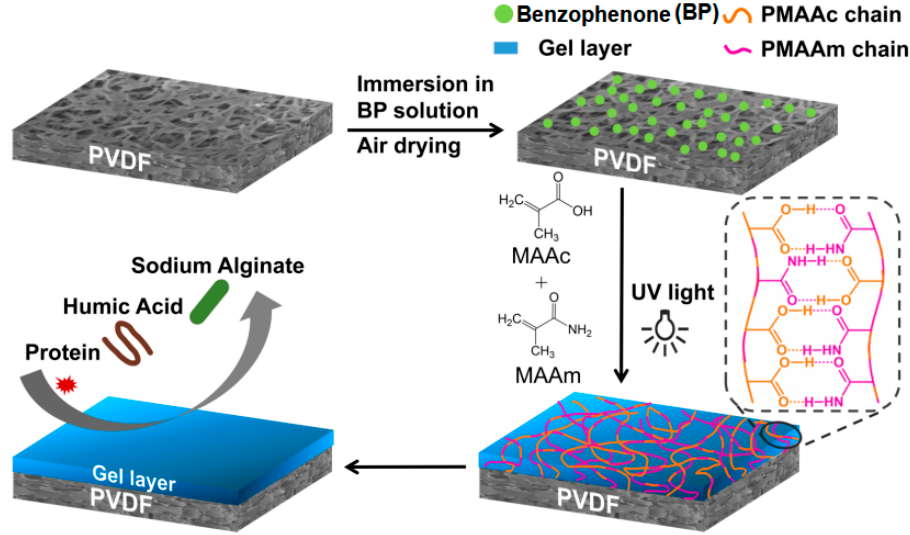
Figure 1. Schematic diagram for modification route of P(MAAc- co -MAAm)-grafted Poly(vinylidene fluoride) (PVDF) membrane.